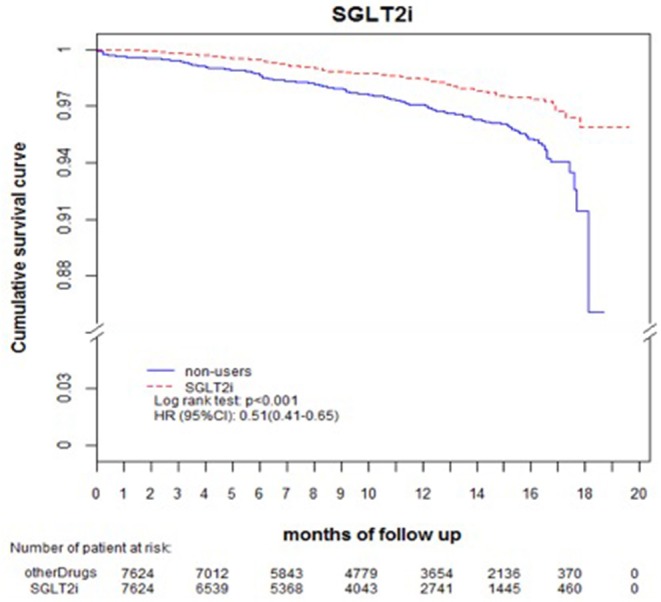
Decrease in eGFR over 40%-free survival rates in the patients with diabetes. The outcome was estimated using Cox regression models stratified according to history of eGFR decrease over 40% for SGLT2 inhibitor users vs. non-users. eGFR, estimated glomerular filtration rate; SGLT2i, sodium–glucose cotransporter 2 inhibitor.